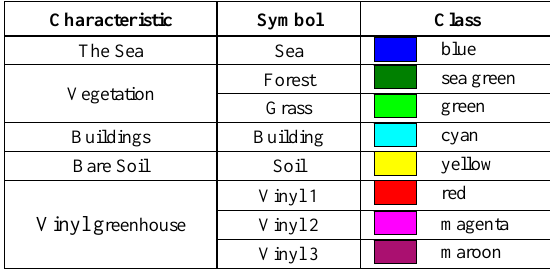
Table 1. Class of Image